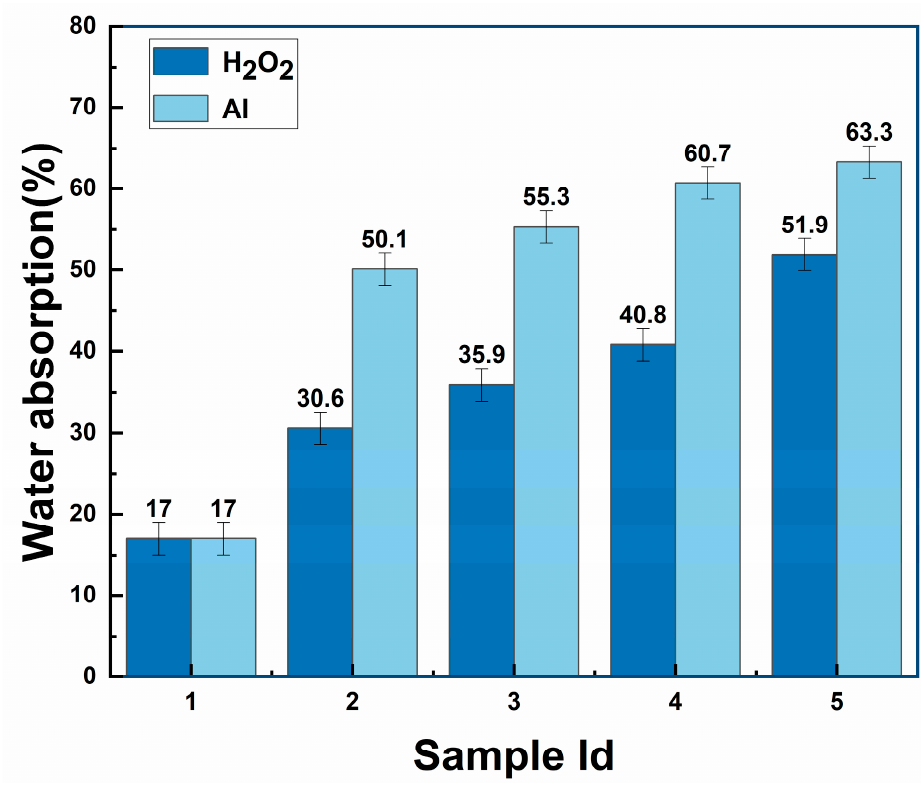
Figure 11. Water absorption (%) of HMNS-FA-phosphate-based porous geopolymers.